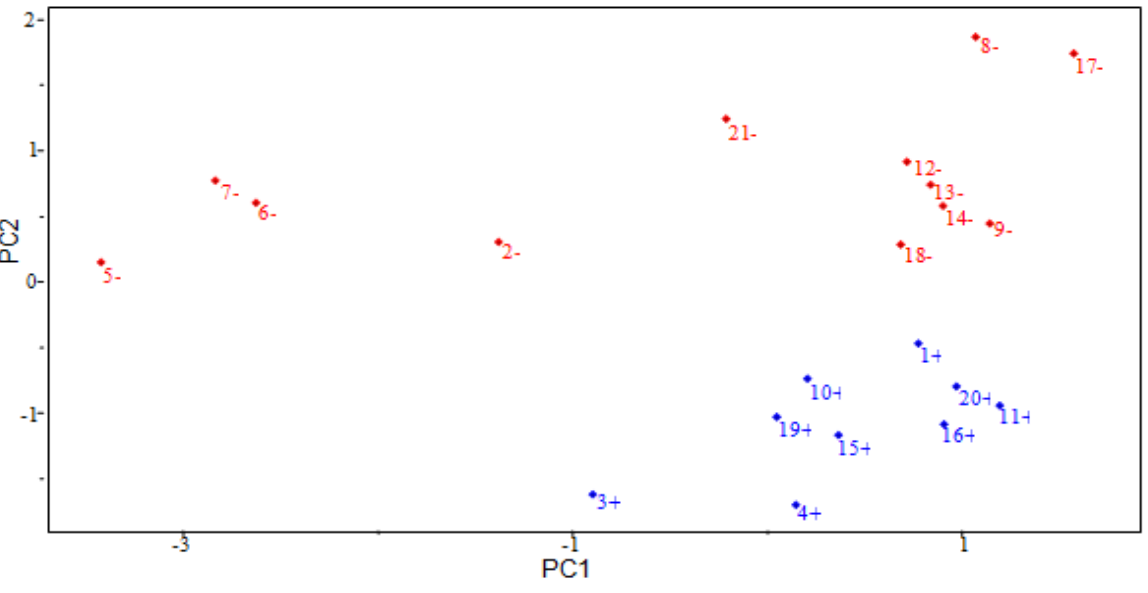
Figure 4. Plot of PC1–PC2 scores for artemisinin and derivatives with antimalarial activity against W-2 strains of P. falciparum . Positive values indicate more potent analogs, and negative values indicate less potent